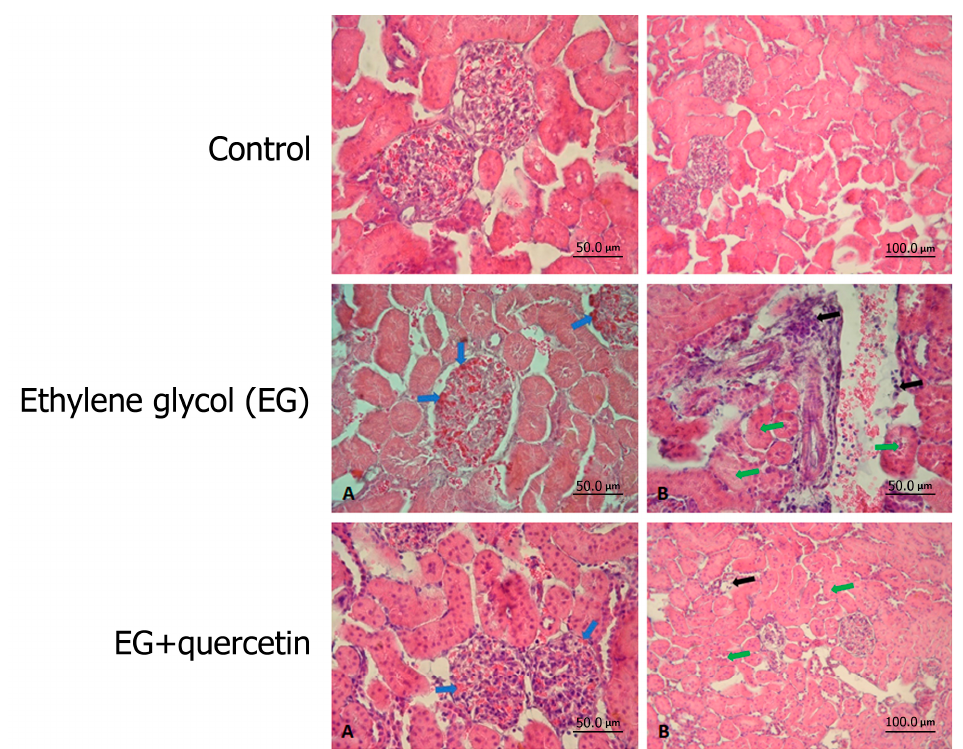
Figure 1. Hematoxylin and eosin (H&E) stain of kidney tissue and histopathological assessment of all groups. Control: Samples with normal kidney tissue structure. Ethylene glycol (EG): (B) Sample with apparent mononuclear cell infiltration in kidney medulla and cortex layers (black arrow), as well as narrowing of the lumen of the tubules (green arrow). (A) Sample with apparent vascular congestion in both medulla and cortical glomeruli (blue arrow). EG + quercetin: (A) In this tissue sample, decreased vascular congestion in both the medulla and cortical glomeruli are observed. (blue arrow). (B) In this tissue sample, decreased mononuclear cell infiltration in renal medulla and cortex layer (black arrow), and a return to normal structure in the lumen of tubules (green arrow) are observed.